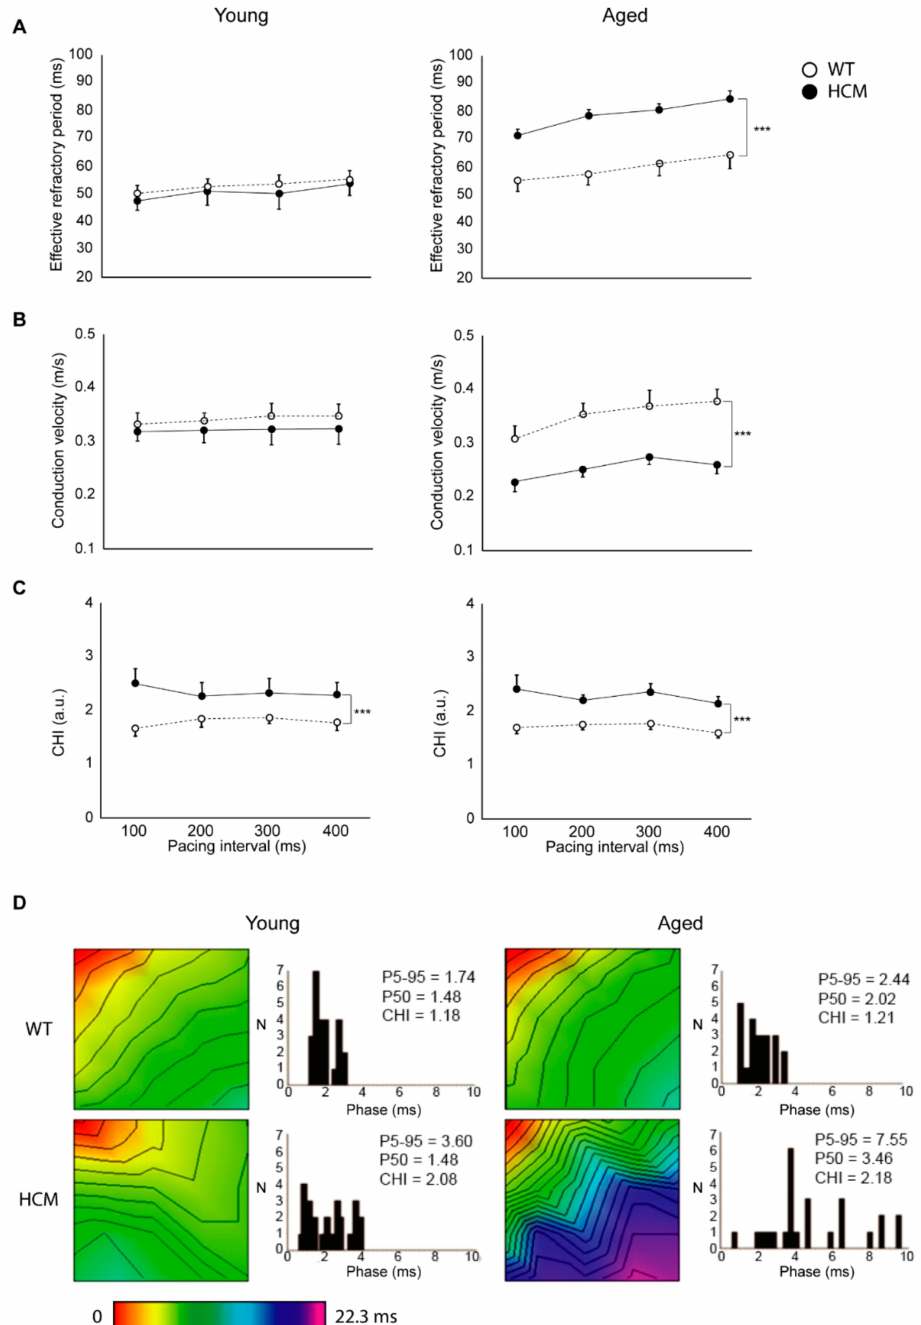
Figure 2. Electrophysiological changes in the HCM left atria (LA). (( A ), left) Young HCM mice demonstrate unchanged effective refractory period (ERP), whereas aged mice (right) exhibit increased ERP across all pacing cycle lengths. (( B ), left) Young HCM mice demonstrate unchanged conduction velocity (CV), whereas aged mice (right) exhibit decreased CV across all pacing cycle lengths. ( C ) Both young (left) and aged (right) HCM mice demonstrate increased conduction heterogeneity index (CHI) as compared to controls across all pacing cycle lengths. ( D ) Representative LA time maps and corresponding phase histograms of mice at 30 weeks and 50 weeks at 200 ms pacing. Phase histograms depict the number of episodes on the y -axis and the largest phase difference within each quadruplet of electrodes on the x -axis. Young HCM mice demonstrate unchanged total activation time but increased conduction heterogeneity progressing to slowed heterogeneous conduction in aged mice. Isochrones (black lines) are constructed at 1 ms intervals. Red indicates the start of the electrical impulse activation and pink represents the longest activation time with intermediate values color coded according to the time scale below. *** p <